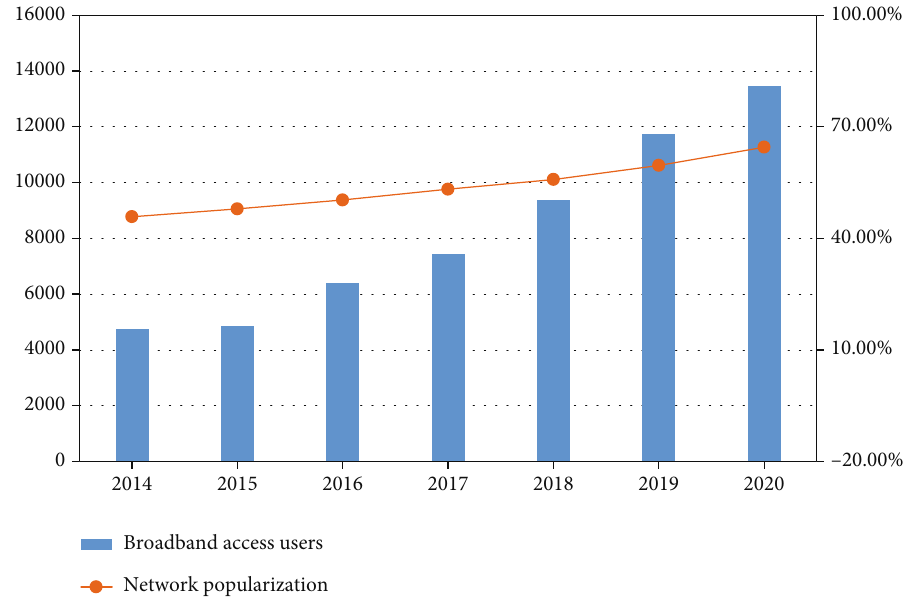
Figure 3: Number of the Internet penetration and broadband access users from 2014 to 2020.